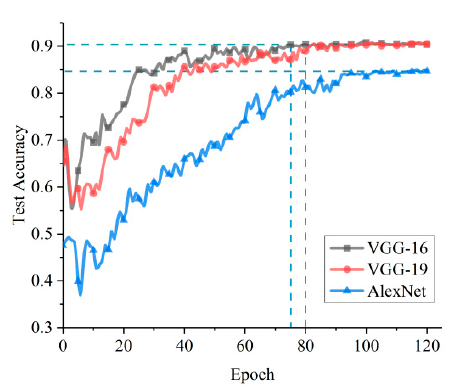
Figure 4. Accuracy of three general deep convolutional neural networks (DCNNs).